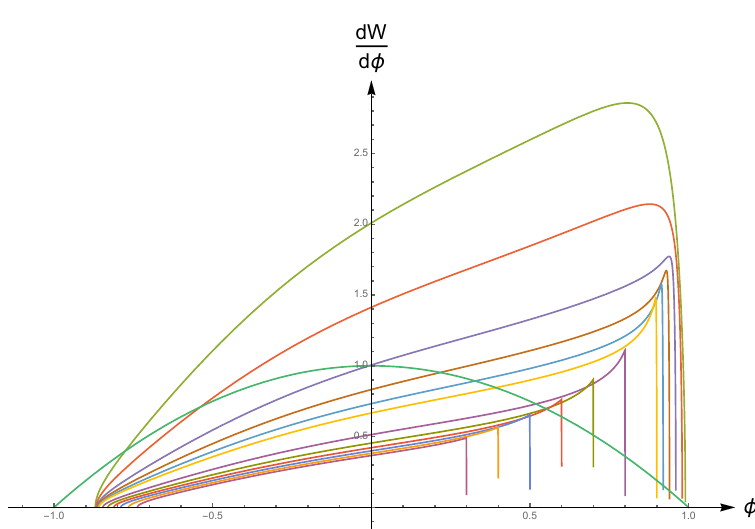
Figure 30 . This (cid:12)gure shows the (cid:12)rst derivative of the functions displayed in (cid:12)gure 30. The curve which extends from (cid:0) 1 to 1 corresponds to the zero-temperature solution. The remaining curves are the derivatives with respect to (cid:30) of the (cid:12)nite-temperature superpotentials displayed in (cid:12)gure 29. The rightmost zero (or the tendance of W 0 to vanish) corresponds to the horizon position which approaches (cid:30) = 1 without reaching it and the leftmost zero corresponds to the bounce position. The closer the horizon is to (cid:30) = 1 the closer the bounce gets to (cid:30) = (cid:0) 1 but the superpotential never reaches (cid:0) 1. This means that the zero-temperature minimum-to-minimum (cid:13)ow is not associated with a black hole. The bouncing points are better visualised in (cid:12)gure 31.